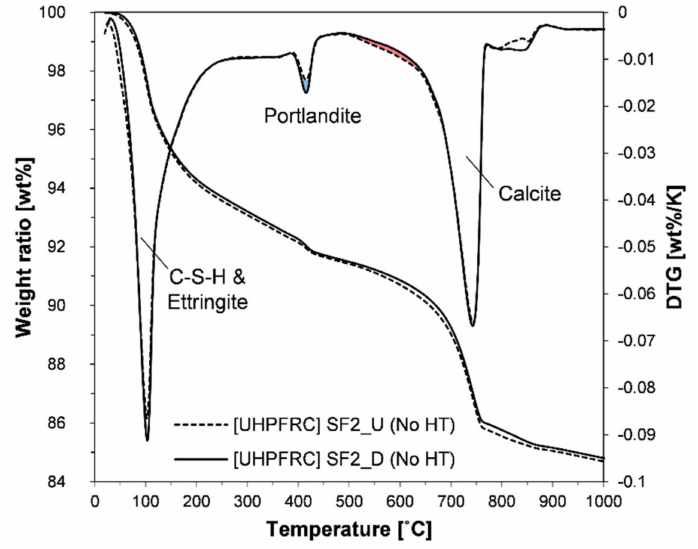
Figure 9. TG and DTG curves of ambient-cured paste samples at 28